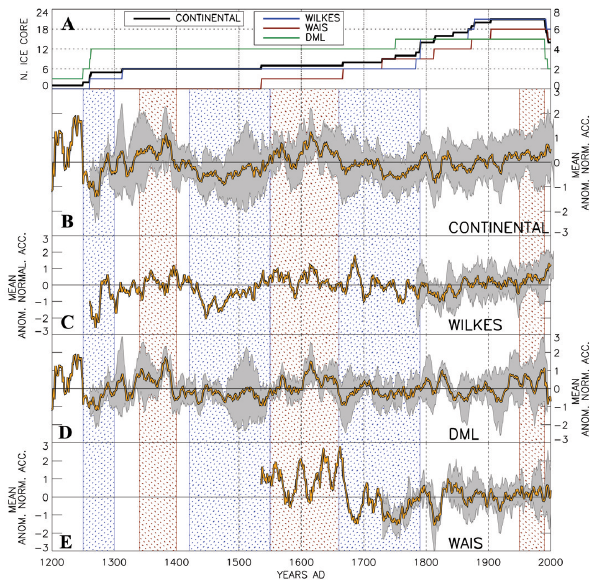
Fig. 4. Mean normalised anomalies of the annually resolved SMB time series at continental and regional scales obtained from the (cid:127) time ice core dataset, as described in the text. (A) Number of records from each year in the period from 1200 to 2000 used to calculate the continental (black line, left y-axis), WILKES, DML, and WAIS stacked records (black, blue, green and red lines, respec- tively, right y-axis). (B) Mean normalised anomalies of the SMB time series at the continental scale. (C) The DML mean normalised anomalies stacked record. (D) The WAIS mean normalised anoma- lies stacked record. (E) The WAIS mean normalised anomalies stacked record along with the ± 1 σ uncertainty standard deviation (grey-filled contour around each stacked record). The blue- and red- filled rectangles represent periods with negative and positive SMBs at the continental scale, respectively, as described in the